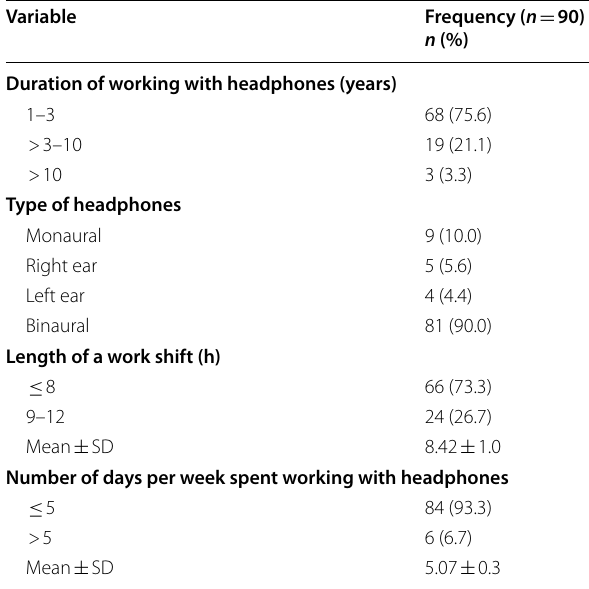
Table 1 Call center operators’ work history